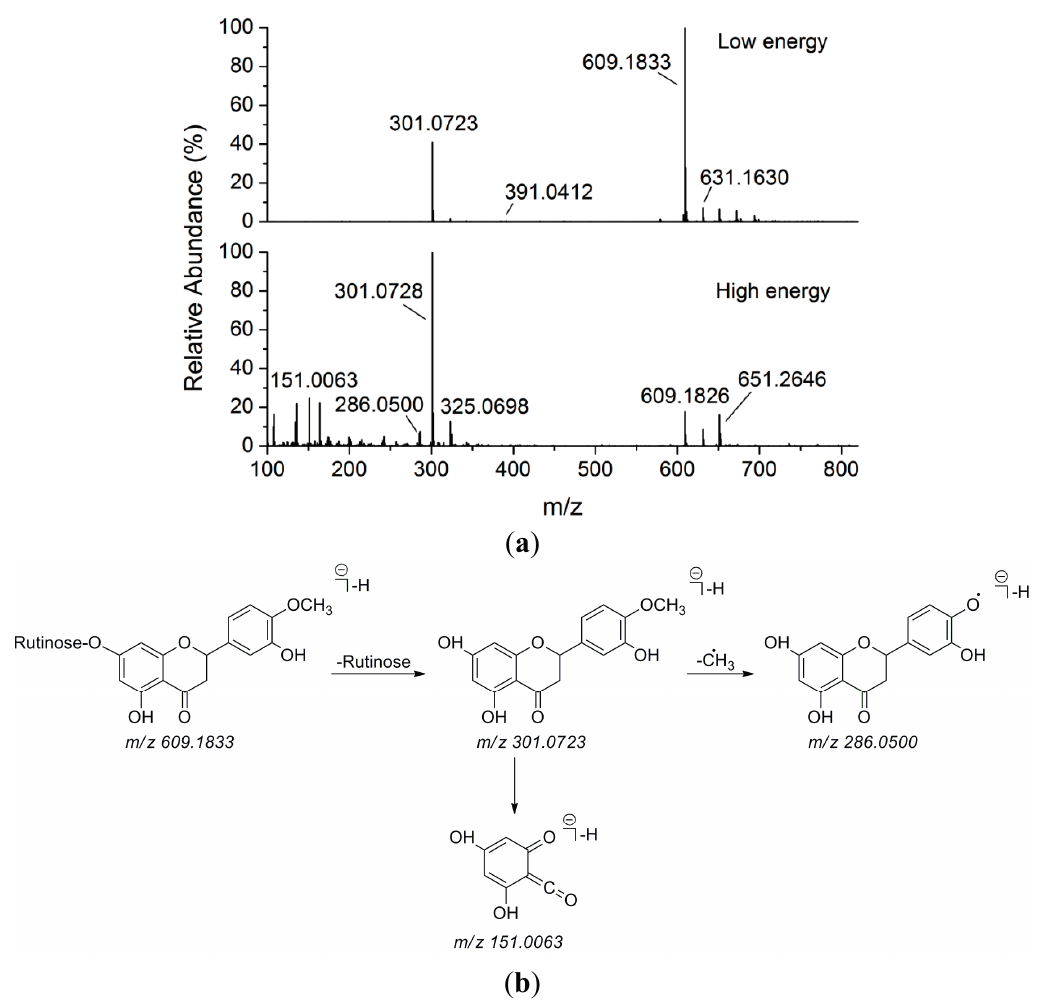
Figure 3. ( a ) ESI( − )-MS and MS E spectra of hesperidin ( 14 ); ( b ) ESI-MS/MS fragmentation pattern of hesperidin ( 14